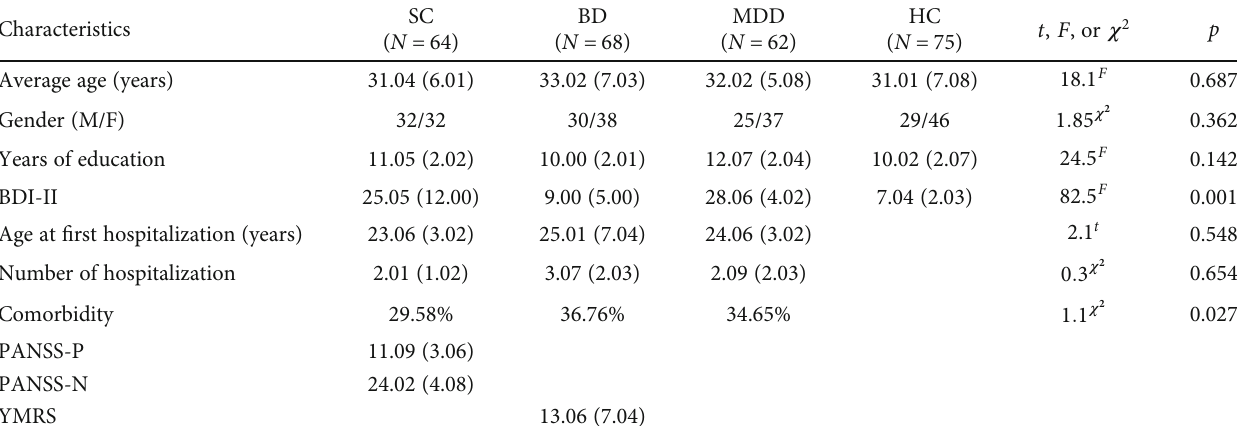
Table 1: Demographic and clinical characteristics of subjects by study